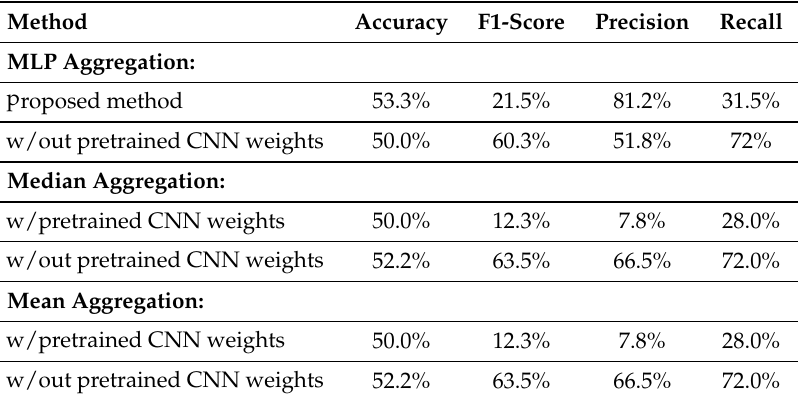
Table 4. Results on the BRCA test